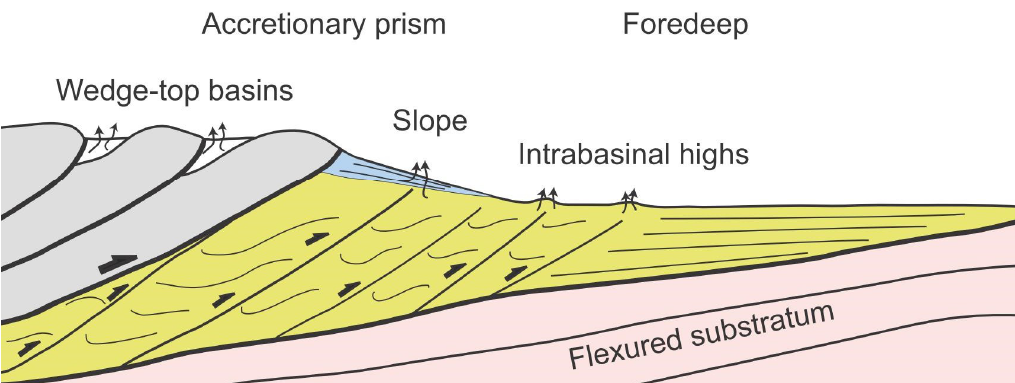
Figure 2. Schematic profile showing the main structural elements of the northern Apennine wedge‐foredeep system hosting hydrate‐related seep‐carbonates during the Miocene: wedge‐top basins (Epiligurian units, white colour) developed on top of allochthonous units (Ligurian units, grey colour), slope sediments (closure facies, light blue colour) and foredeep basin (Umbro‐Marchean units, yellow colour). Intrabasinal highs developed in the inner sector of the foredeep. The position of methane seeps on the seafloor is here indicated by black arrows.